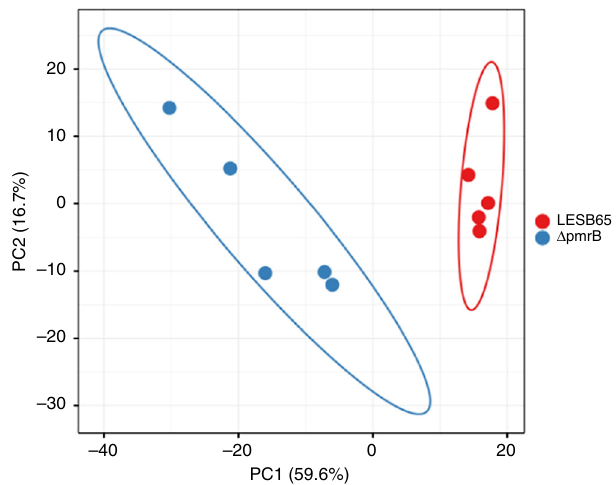
Fig. 2 Principal component biplot of LESB65 and Δ pmrB proteomics data showing proteins with signi fi cantly different abundance between samples. Five biological replicates were performed for each isolate. Unit variance scaling is applied to rows; SVD with imputation is used to calculate principal components. X axis and Y axis show principal component 1 and principal component 2 that explain 59.6% and 16.7% of the total variance, respectively. Prediction ellipses are such that with probability 0.95, a new observation from the same group will fall inside the ellipse. PCA analysis of the full dataset, with all detected proteins, can be found in Supplementary Fig. 4